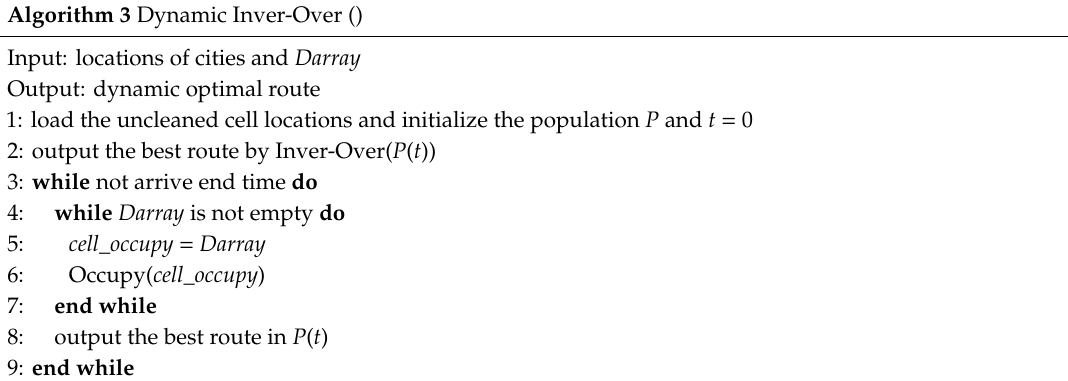
Algorithm 3 Dynamic Inver-Over ()